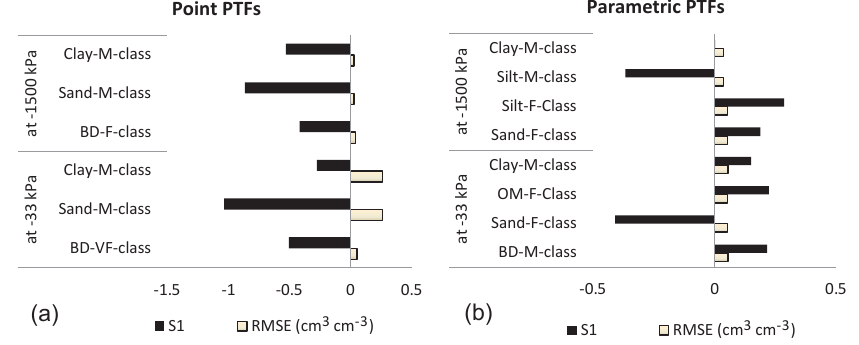
Figure 6. Variation in first sensitivity index with RMSE after textural grouping.